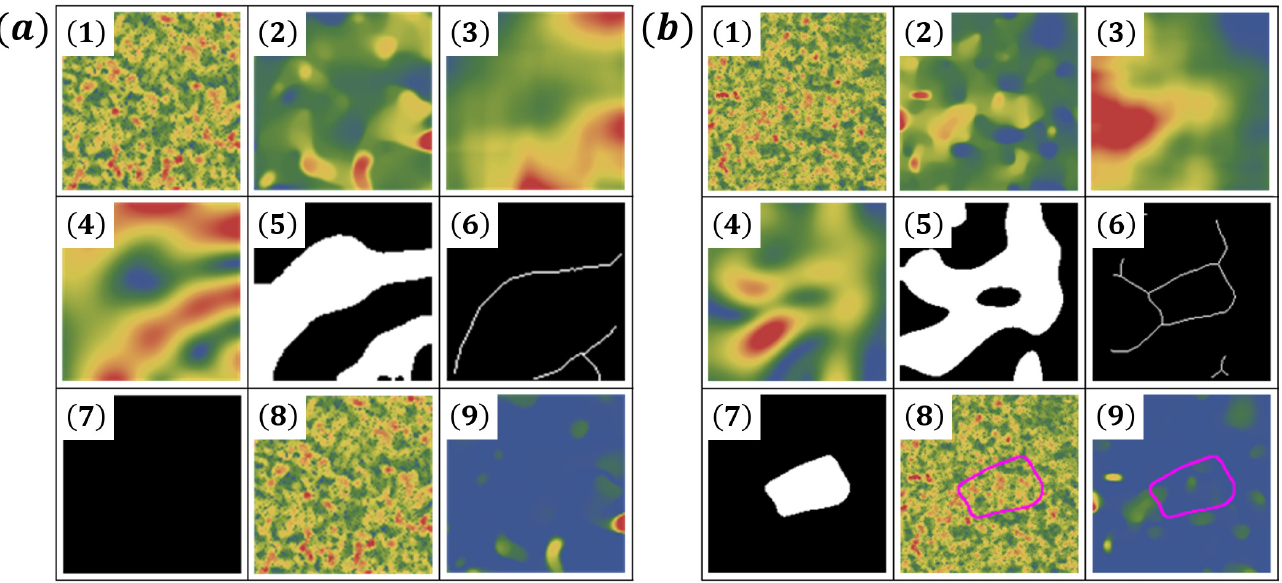
Figure 9. Updating a first segment estimate using the local filter (Algorithm 5): ( a ) first estimate in an IW; ( b ) original pre- processed image projected onto the IW; ( c ) SSCF output projection onto the IW (Algorithm 3); ( d ) mean-filtered SSCF output; ( e ) gradient filter output; ( f ) Chan–Vese segmentation output; ( g ) edges extracted via erosion and thinning; ( h ) updated local segment for the IW. Segment filling and cleanup are similar to what is done in Algorithm 3.